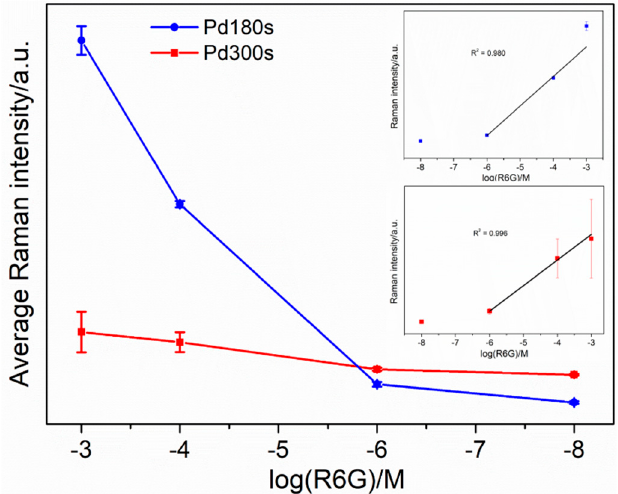
Figure 7. Relationship between the logarithm of R6G concentration and the average SERS intensity at 1652 cm − 1 and the related error bars. Insets: the SERS intensity at 1652 cm − 1 as a function of the logarithmic R6G concentrations with the corresponding calibration curve (in black) for Pd180s (top inset) and Pd300s (bottom inset).